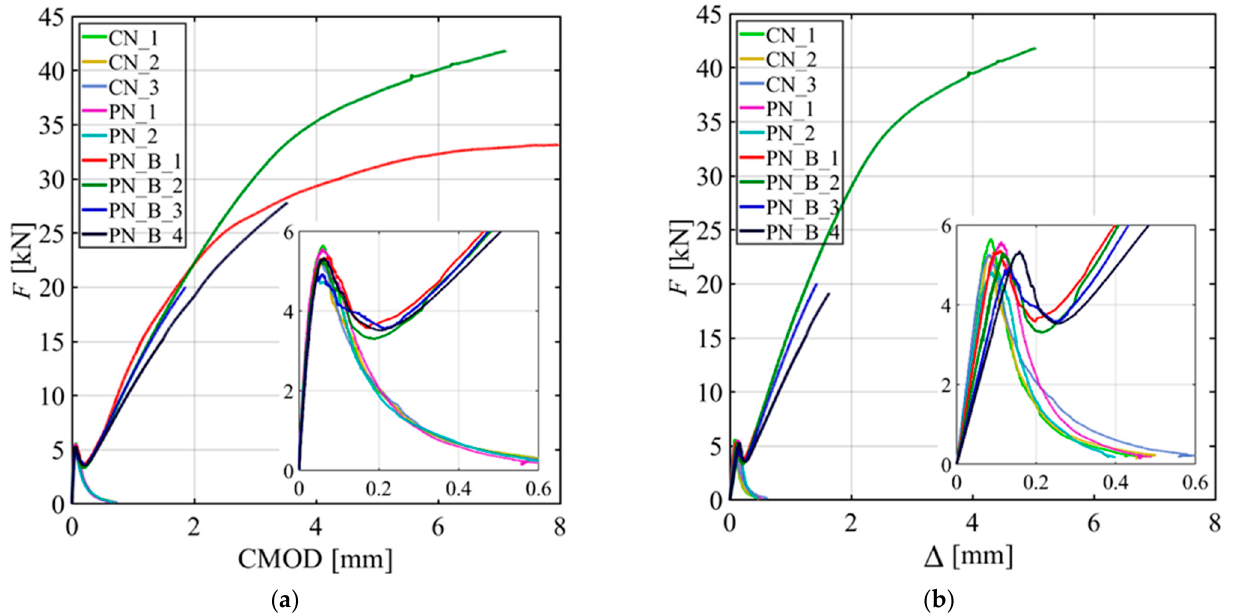
Figure 6. Load responses for all specimens: ( a ) F- CMOD responses; and ( b ) F - Δ responses.